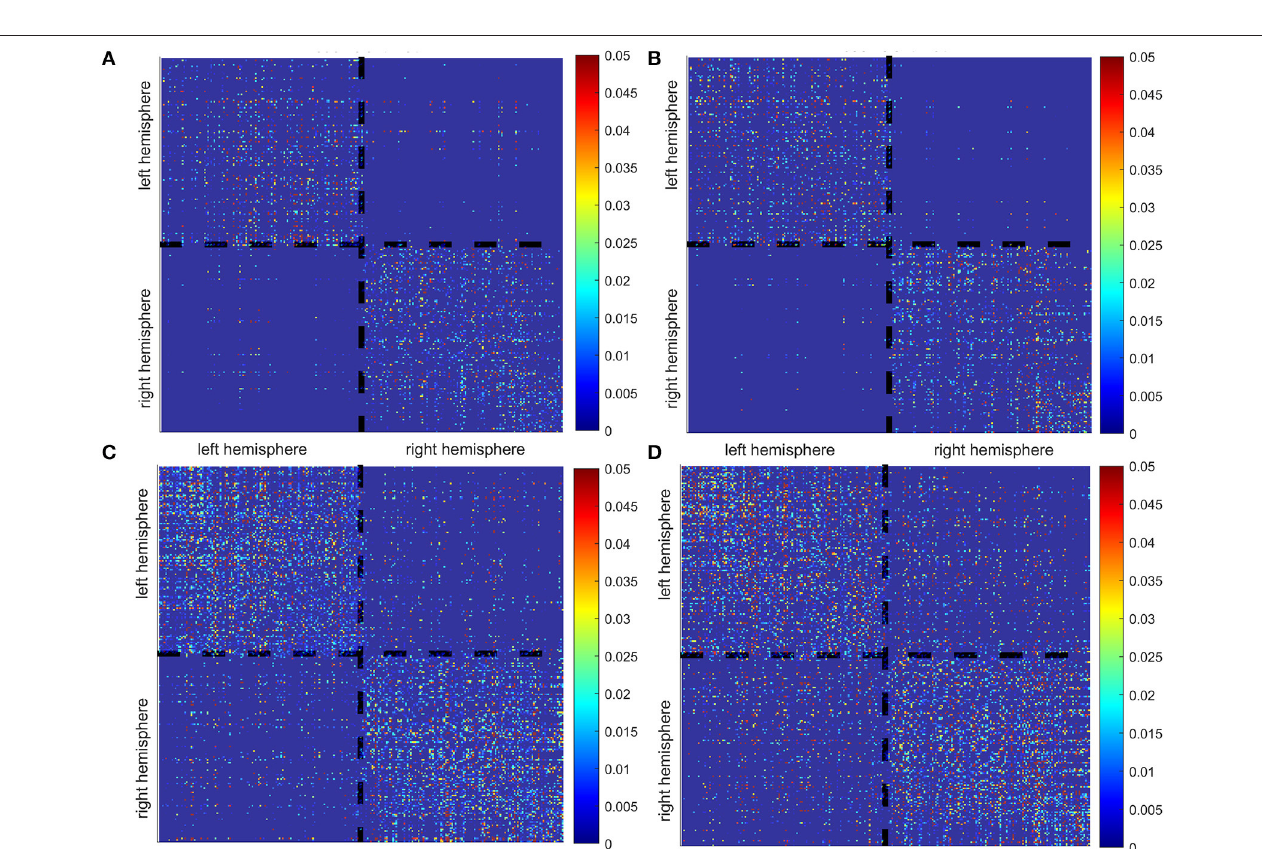
FIGURE 6 | Matrices of the LCD model coefficients for controls (A,B) and stroke participants (C,D) .